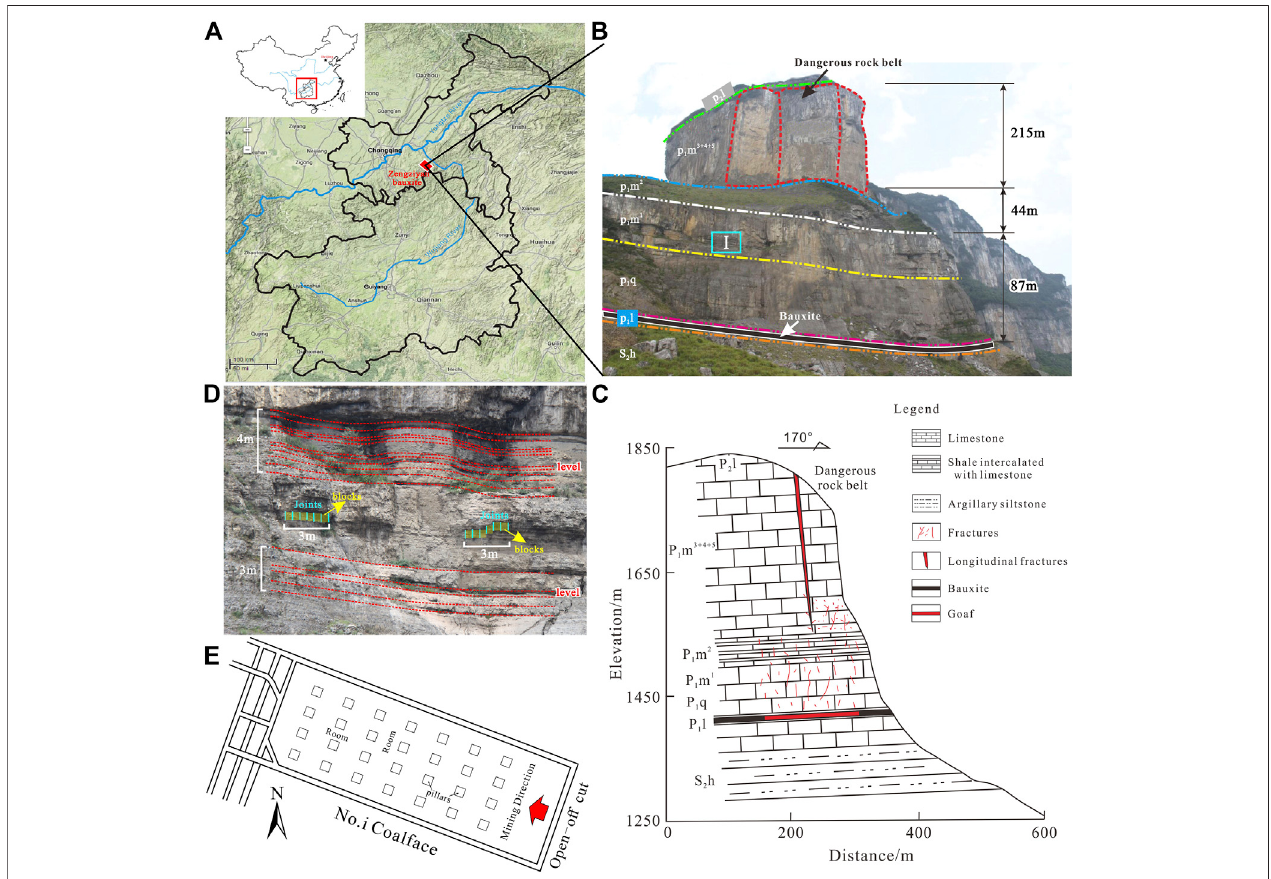
FIGURE 1 | Zengziyan Bauxite Mine in Nanchuan District, Chongqing: (A) Location of Zengziyan Bauxite Mine (refer to Feng et al., 2014); (B) Mining geological conditions; (C) Section of overlying strata; (D) Stratigraphic structure (region I in Figure 1B ); (E) Room-and-pillar mining face.